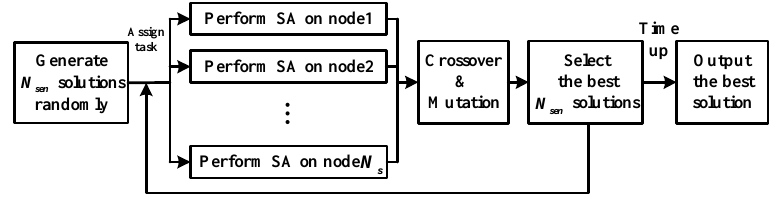
Figure 2. Flow chart of distributed genetic algorithm and simulated